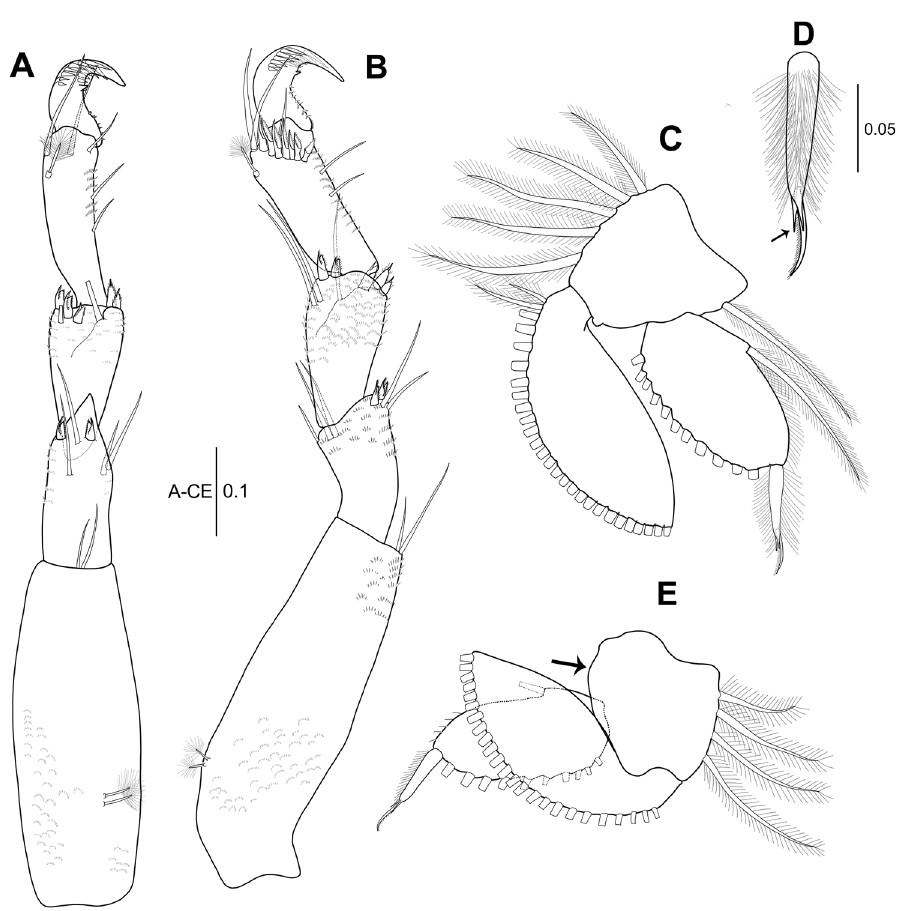
Figure 4. Hexapleomera ulsana sp. n., female holotype, A pereopod 5 B pereopod 6 C pleopod 1 D distal seta of pleopod1 endopod E pleopod 3. Scale bars in